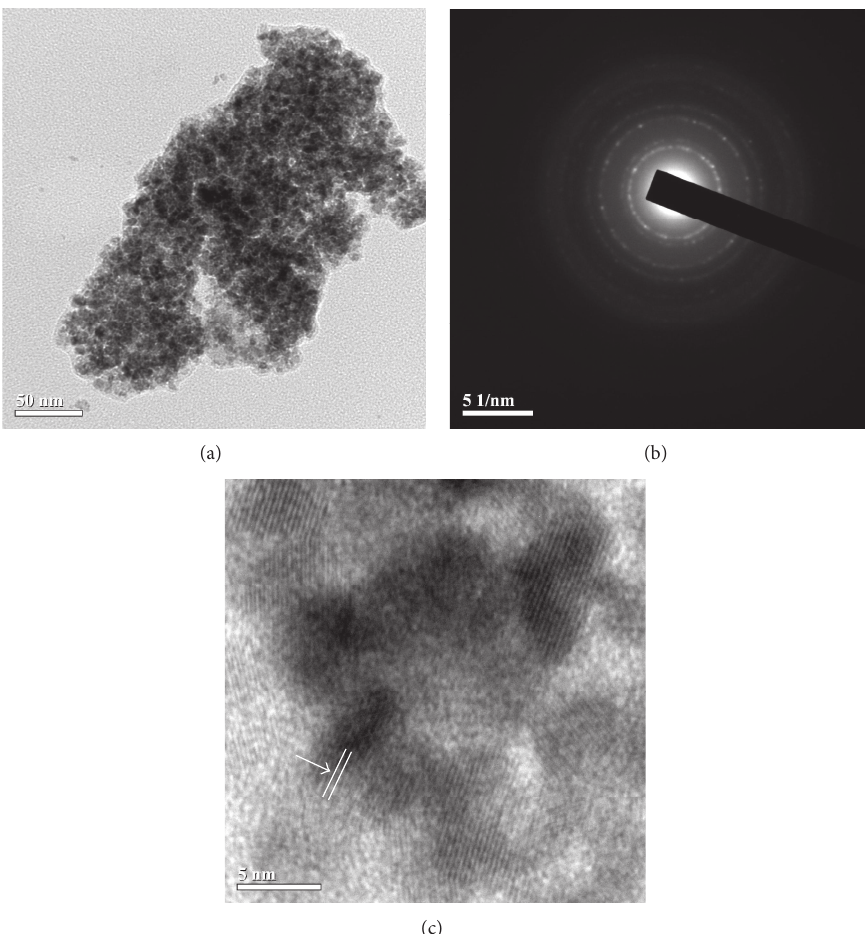
Figure 2: TEM results of 20% CuO/CeO 2 : (a) typical TEM image, (b) SAED, and (c) HRTEM images.